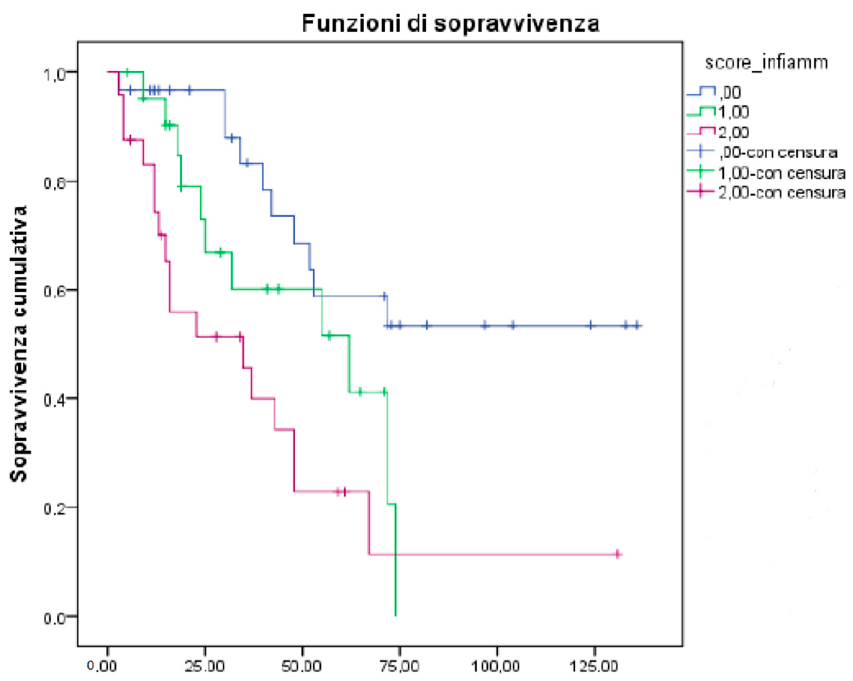
Figure 3. Platinum status in correlation to OS. PFI > 12 months (blue line); PFI 6–12 months (green